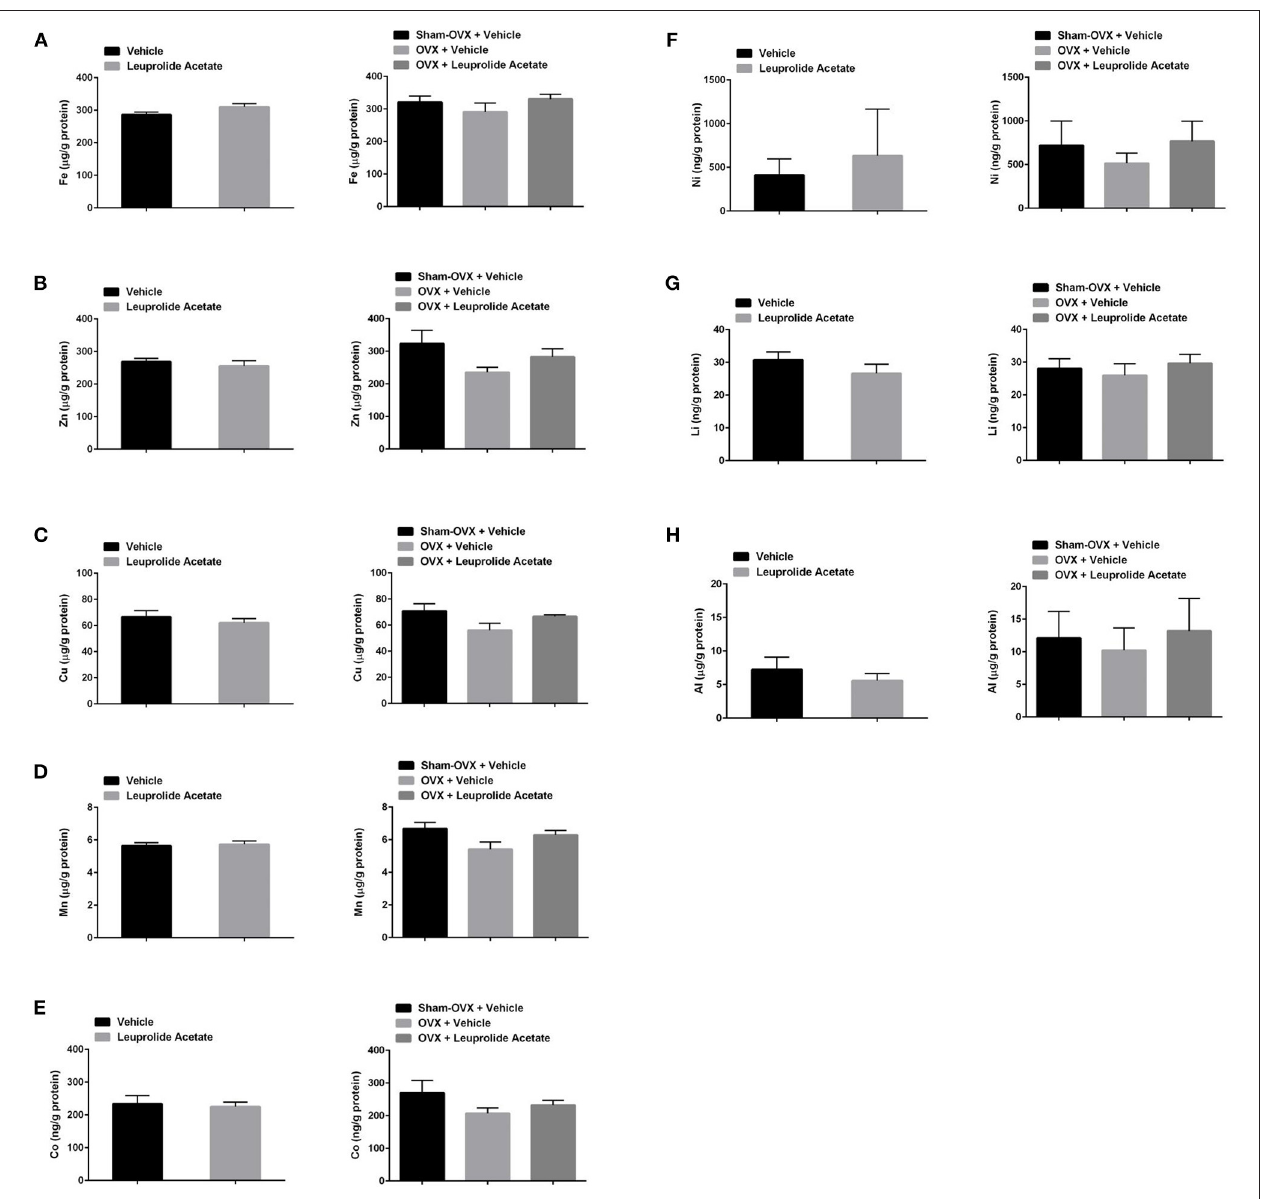
FIGURE 3 | Changes in brain metal ion concentrations with ovariectomy and leuprolide acetate treatment of mice. Mice as described in Figures 1 , 2 were sacrificed after 9 months of treatment, and their brains collected for metal analysis with ICP-MS. Samples were corrected for trace amounts of metals from buffer, and the concentration of metal ion was normalized to total protein in the samples. (A) Fe, (B) Zn, (C) Cu, (D) Mn, (E) Co, (F) Ni, (G) Li, and (H) Al. Results are presented as µ g/mg or ng/mg protein; mean ± SEM, n =